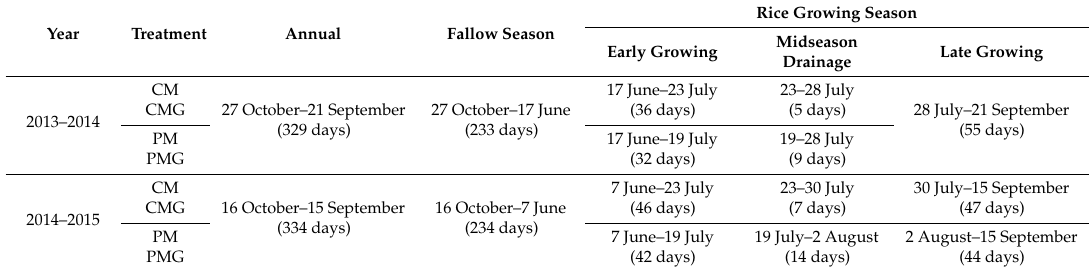
Table 2. Accumulation period of methane and nitrous oxide emissions and heterotrophic